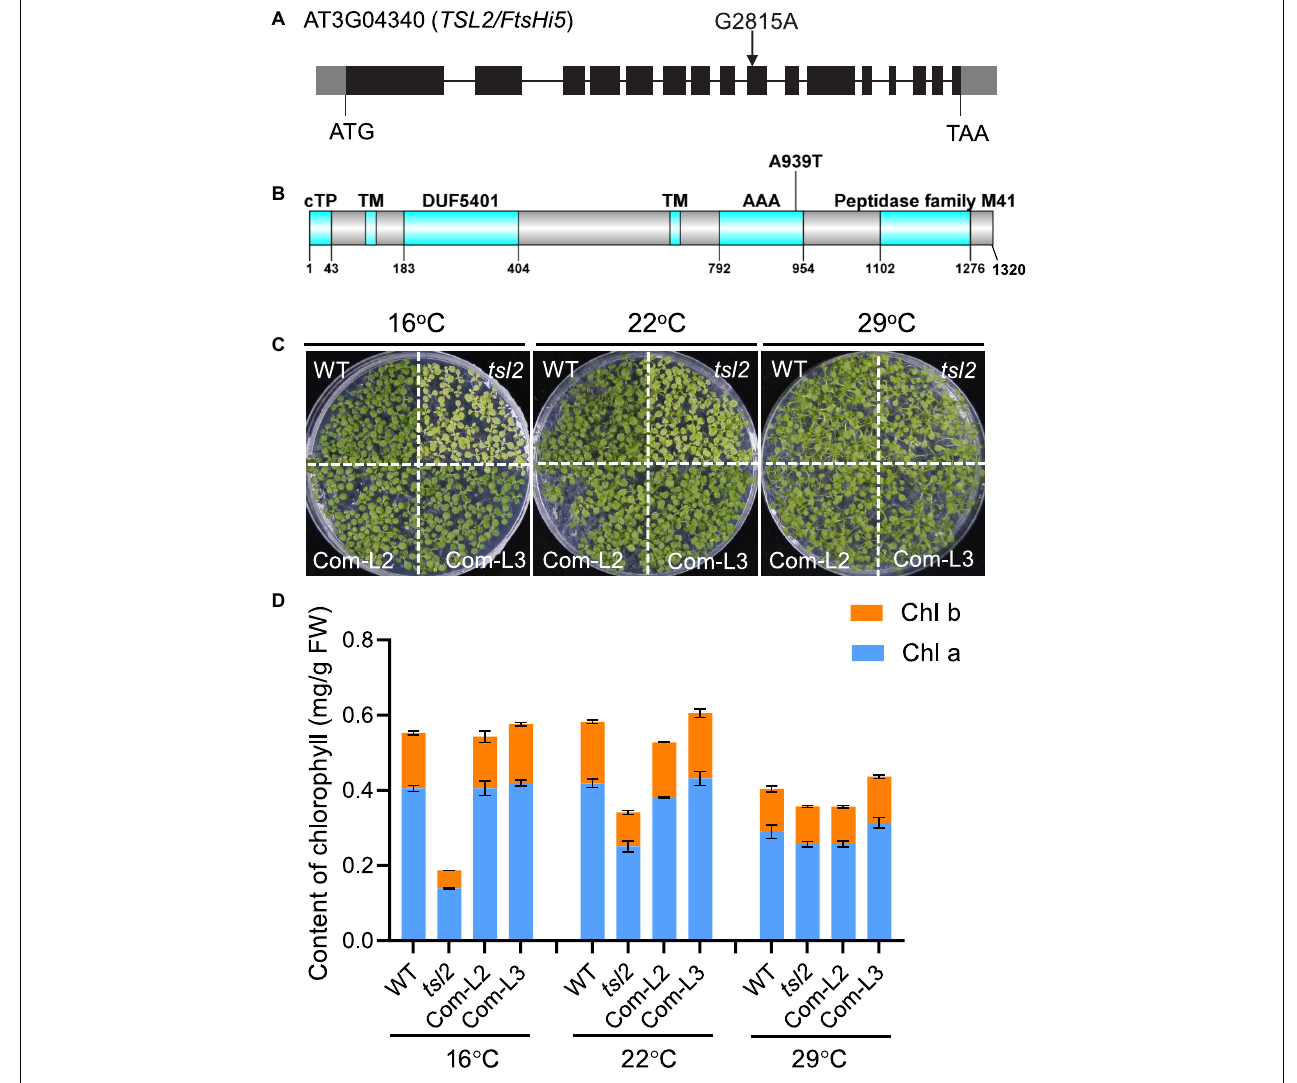
FIGURE 2 | The tsl2 mutant phenotype is complemented by TSL2 / FtsHi5 . (A) Gene structure and mutation sites of TSL2 / FtsHi5 in the tsl2 mutant. Gray boxes represent the 5 (cid:48) - and 3 (cid:48) -untranslated regions, black boxes represent exons and lines represent introns. (B) Protein domains of TSL2. cTP, chloroplast transit peptide; TM, transmembrane domain; DUF5401, the domain of unknown function 5401; AAA, ATPase family associated with various cellular activities. (C,D) Phenotypic analysis of the complemented lines (Com-L2 and Com-L3). The data represents the average of samples and the error bars indicate the standard error ( n =